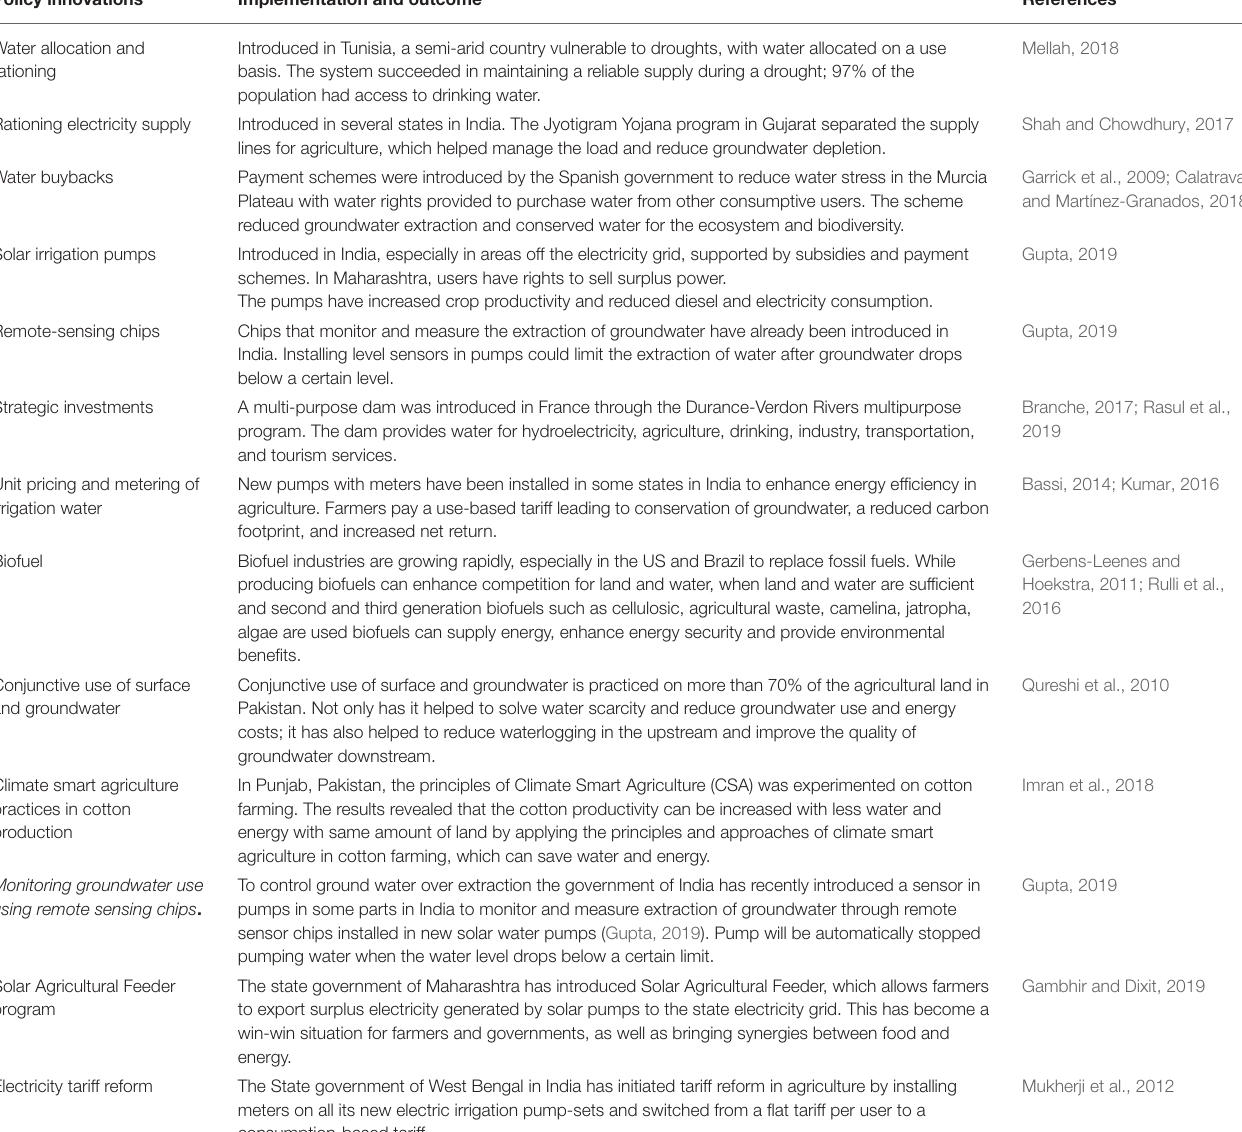
TABLE 2 | Examples of nexus focused policy innovation in South Asia and